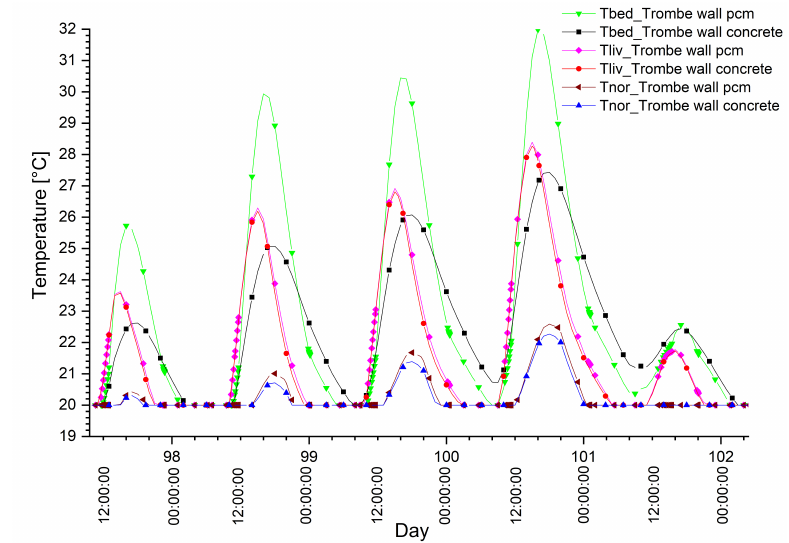
Figure 19. Comparison of temperatures in the living room and north-facing rooms for the case of the bedroom fitted with the PCM and concrete solar Trombe